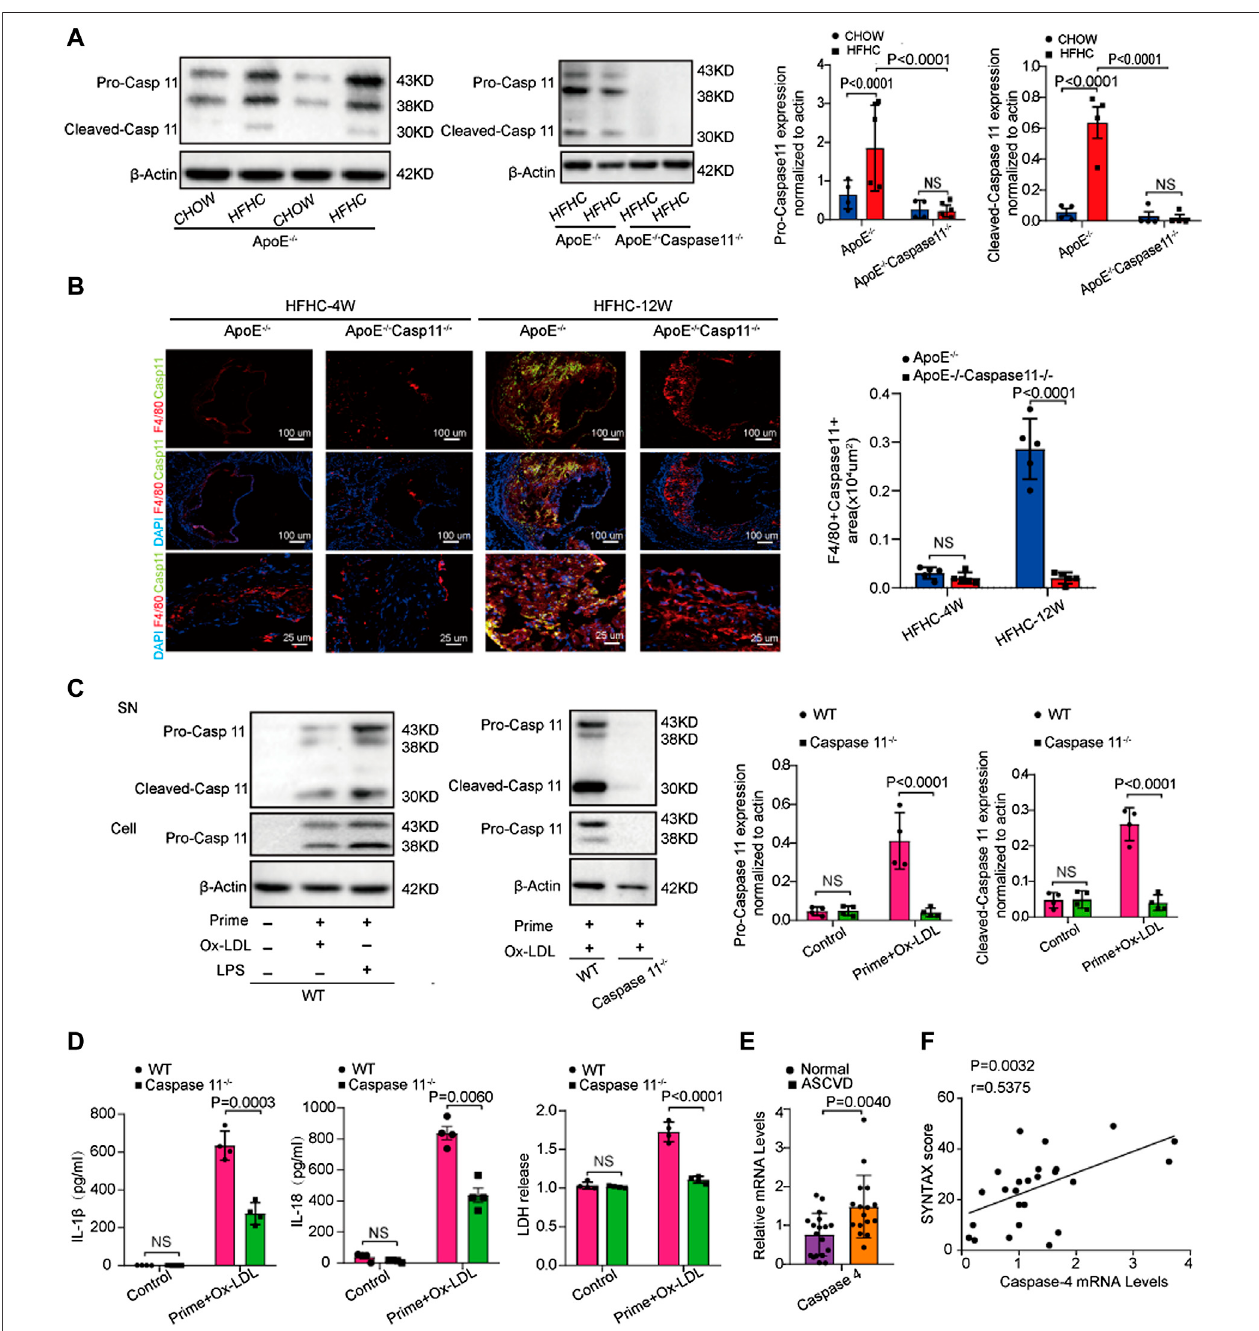
FIGURE 2 | Caspase-4/11 accelerates lipid-promoted atherosclerosis and ox-LDL-treated macrophage pyroptosis. (A) Left, western blot analysis and quanti fi cationofcaspase-11anditscleavedfragmentexpressioninaorticarteriesfromWT,ApoE − / − ,andApoE − / − Caspase-11 − / − micefedwithchowdietandHFHCdiet for twelve weeks ( n (cid:2) 4 per group). Middle, quanti fi cation results of the level of cleaved caspase-11 in indicated groups. Right, quanti fi cation results of the level of pro- caspase-11 in indicated groups. (B) Left, representative images of caspase-11 (green), F4/80 (red) and DAPI (blue) in immuno fl uorescent staining of aortic root sections ofindicatedgroup,andquanti fi cationoftheF4/80andcaspase-11positiveareaofaorticrootsections( n (cid:2) 4pergroup). Right,quanti fi cationresultsofthelevel of F4/80 and caspase-11 positive area of aortic root sections in the indicated groups. (C) Left, representative immunoblots of cleaved caspase-11 in peritoneal macrophage primed with 16-h ox-LDL stimulation in the indicated groups ( n (cid:2) 4 per group). Right, quanti fi cation results of the level of cleaved caspase-11 in indicated groups. (D) IL-1 β (Left), IL-18 (Middle) and LDH release (Right) level secreted in peritoneal macrophage primed with LPS for 5 h and then treated with ox-LDL for 16 h after LPS administration was measured via enzyme-linked immunosorbent assay (ELISA) kits ( n (cid:2) 4 in each group). (E) Quanti fi cation results of the mRNA levels of caspase-4genesinperipheralbloodmonocytes inpatients withcoronaryheartdiseases andthecontrolgroup( n (cid:2) 10ineachgroup). (F) Pearsoncomparison analyses of the correlations between caspase-4 mRNA levels in PBMC and SYNTAX score of patients with coronary heart diseases ( n (cid:2) 25). p < 0.05 for all of these correlations,